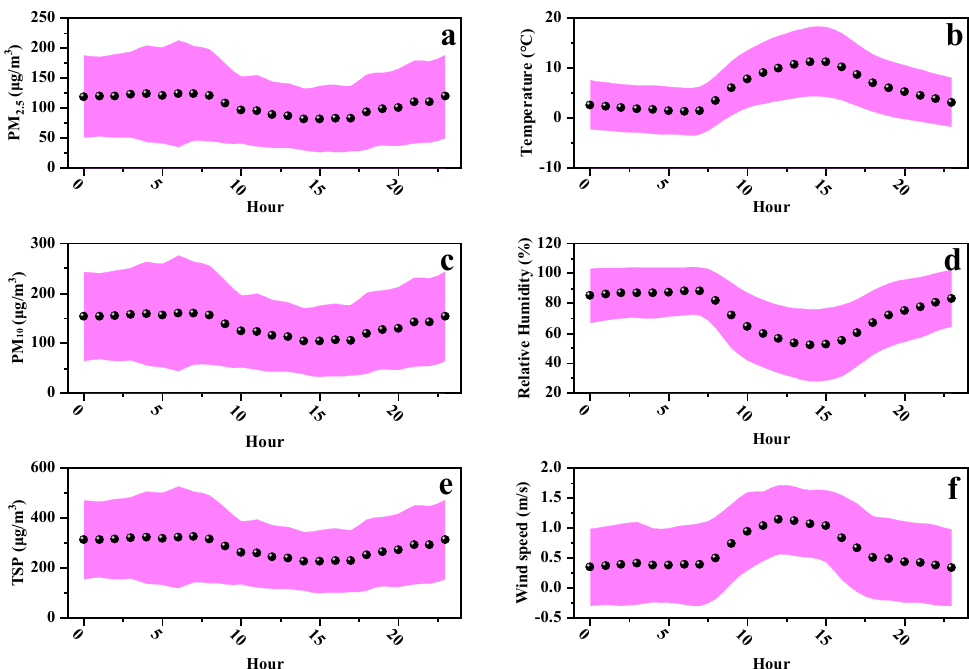
Figure 5. Daily trends of each variable at the NYNU station during the experimental cycle. Black dots represent the mean and red areas represent the standard deviation of ( a ) PM 2.5 (µg/m 3 ); ( b ) Temperature (°C); ( c ) PM 10 (µg/m 3 ); ( d ) Humidity (%); ( e ) Total suspended particulate matter TSP (µg/m 3 ); ( f ) Windspeed (m/s).